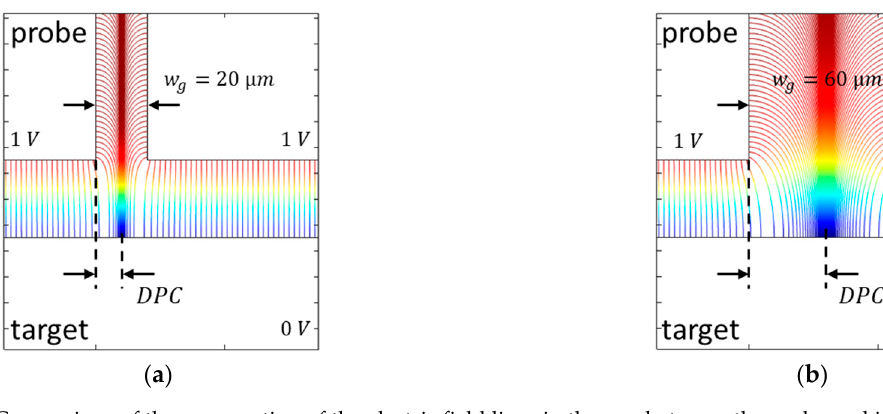
Figure 14. Comparison of the propagation of the electric field lines in the gap between the probe and its guard ring for ( a ) a small gap width and ( b ) a large gap width. The field lines of the side surfaces of the probe and the guard ring converge in the middle of the gap. For wider gap widths, the distance between the probe and the center of the converging field lines (DPC) becomes larger, and the distortion of the electric field lines increases.